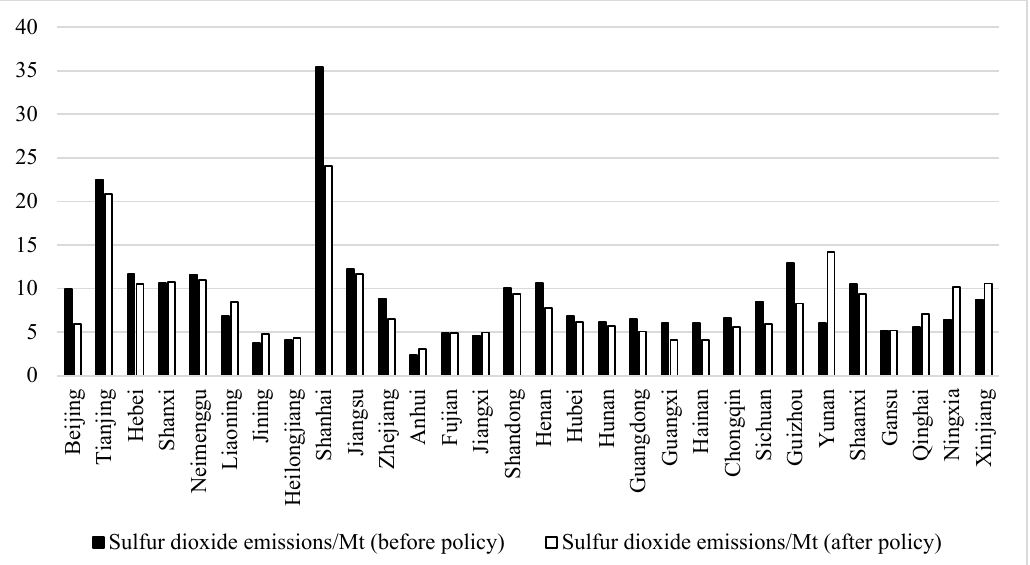
(or after) the implementation of the policy is selected to represent the average performance level of enterprises before (or after) the implementation of the policy, which is represented by the dotted line (or the solid lines) in the Figure 4. As shown in Figure 4, the dotted line is always above the solid line, indicating that after the implementation of the policy, the average SO 2 emissions intensity of enterprises in the pilot area has been reduced, and the environmental performance of enterprises has improved. Therefore, we preliminarily determine that the SO 2 ETS can improve the environmental performance of pilot areas.